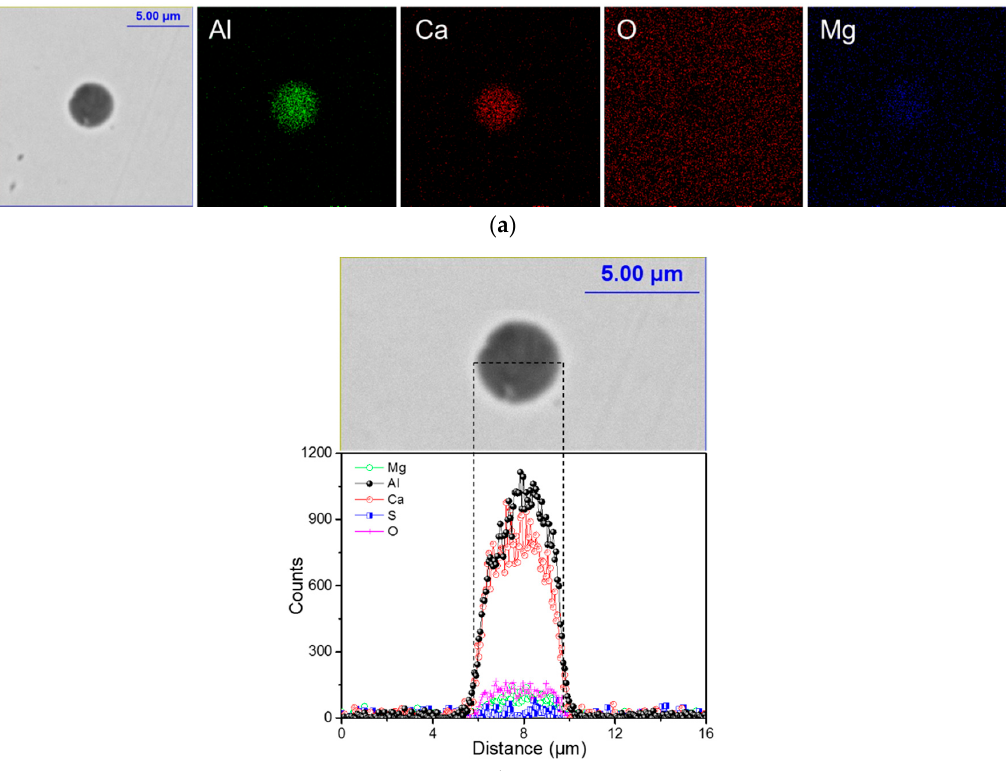
Figure 3. Composition and size of inclusions in steel samples: ( a ) Before and after heat treatment at 1498 K for ( b ) 5 min, ( c ) 20 min, ( d ) 1 h, ( e ) 3 h, ( f ) 7 h, ( g ) 12 h.